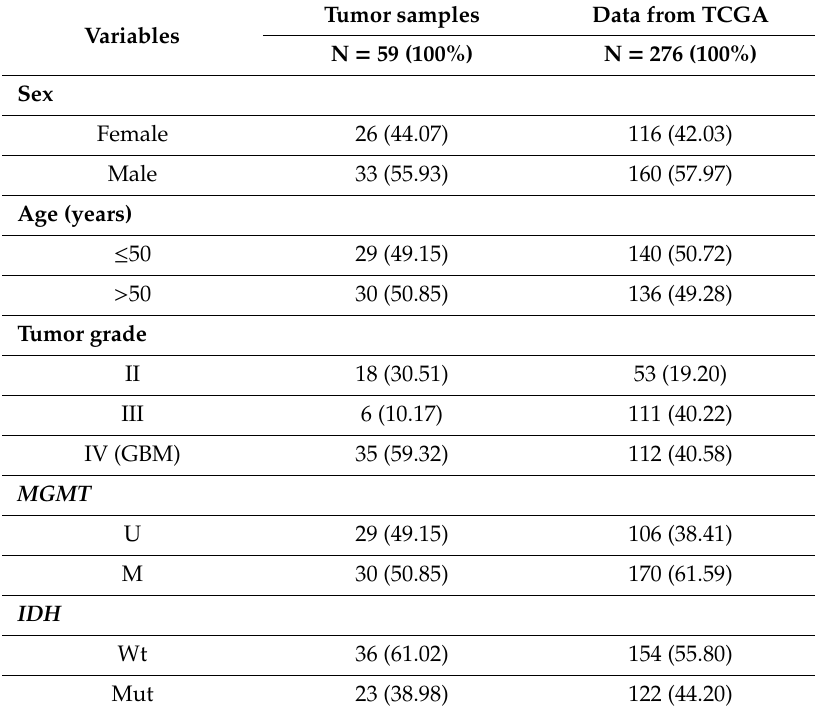
Table 3. Summary of patient clinicopathological